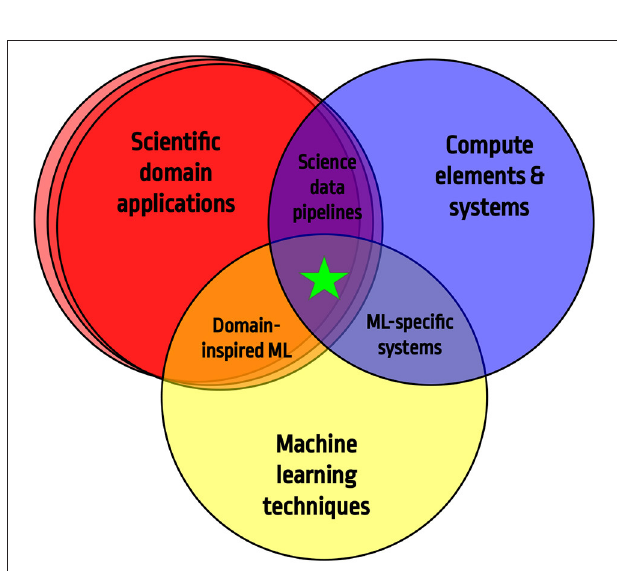
FIGURE 1 | The concept behind this review paper is to find the confluence of domain-specific challenges, machine learning, and experiment and computer system architectures to accelerate science